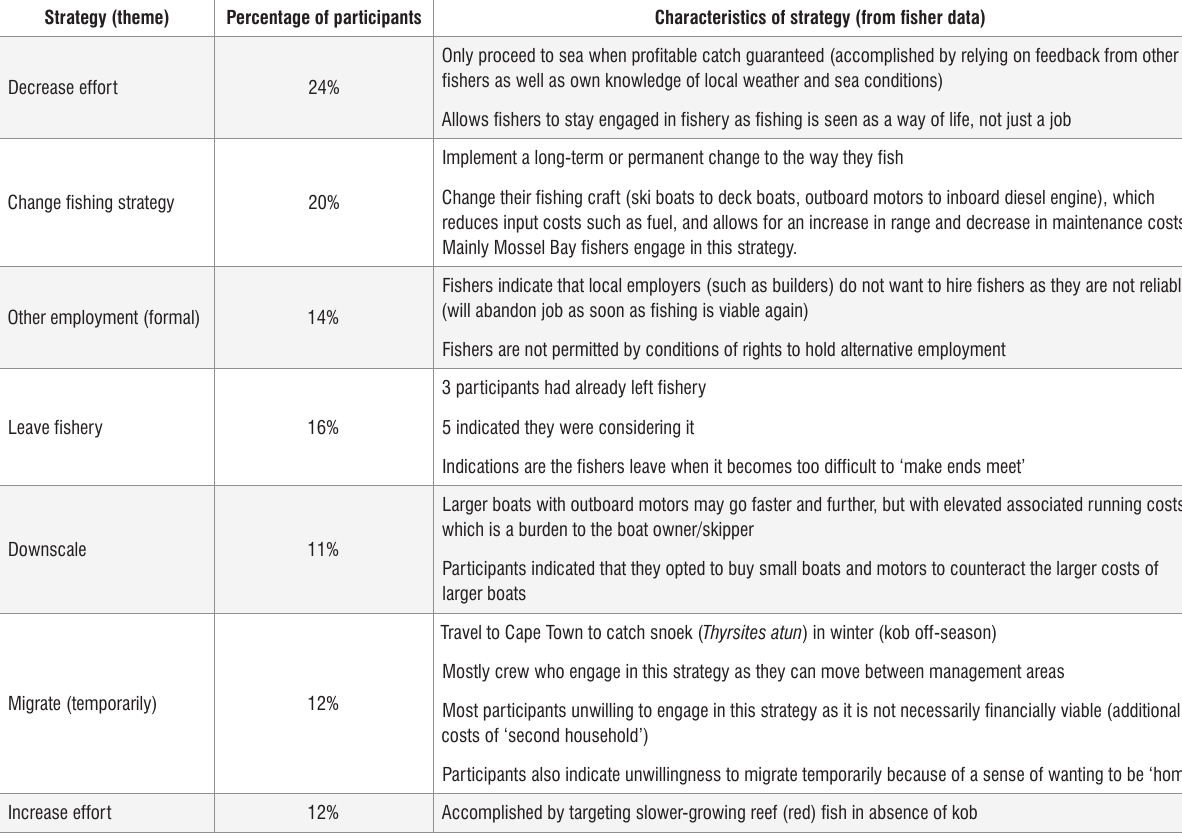
Response strategies for which a positive response was recorded by less than 25% of participants Percentage of participants Characteristics of strategy (from fisher